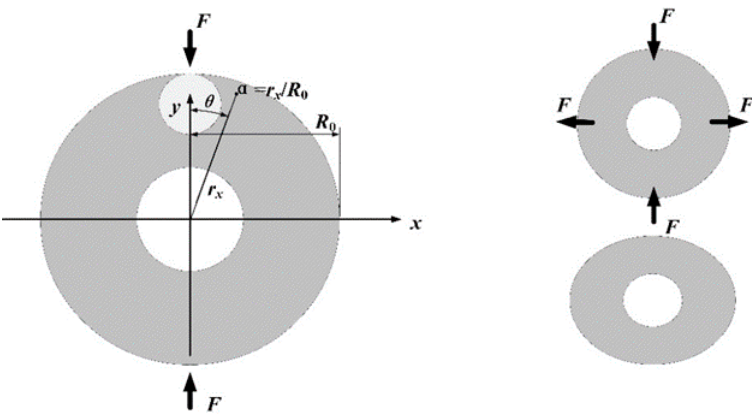
Figure 8. A simplified model of disk resonator deformation.